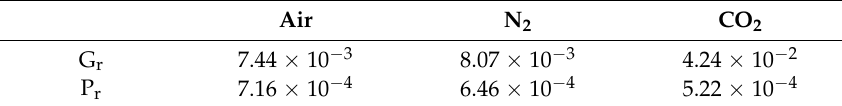
Table 2. Calculated G r and P r